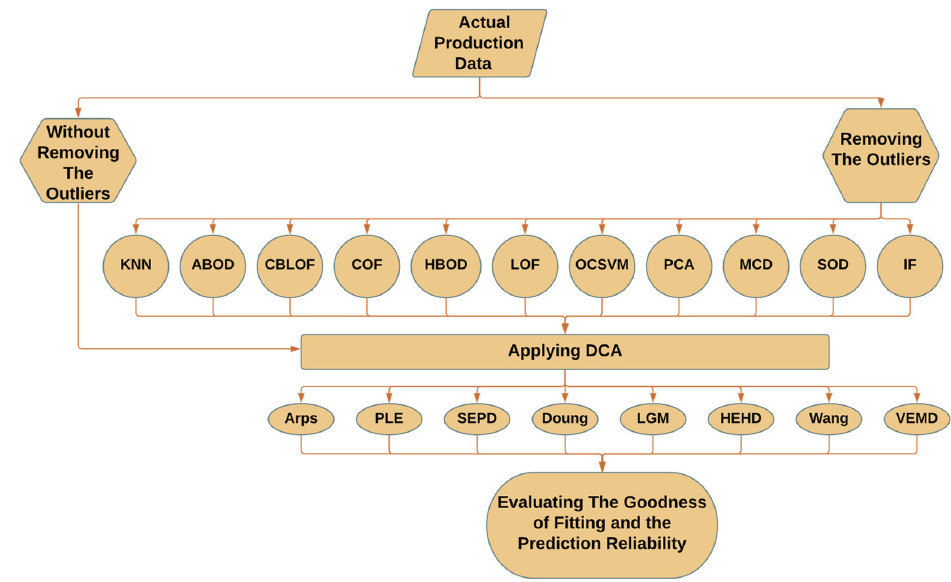
Figure 15. A scheme of the methodology used in this research.